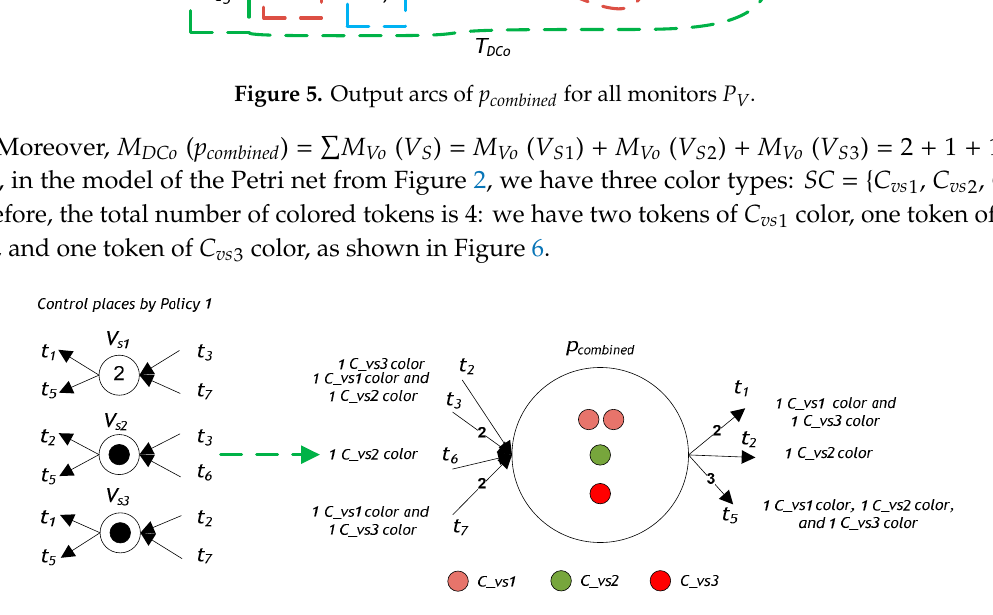
Figure 6. Merged controller for all monitors P V .